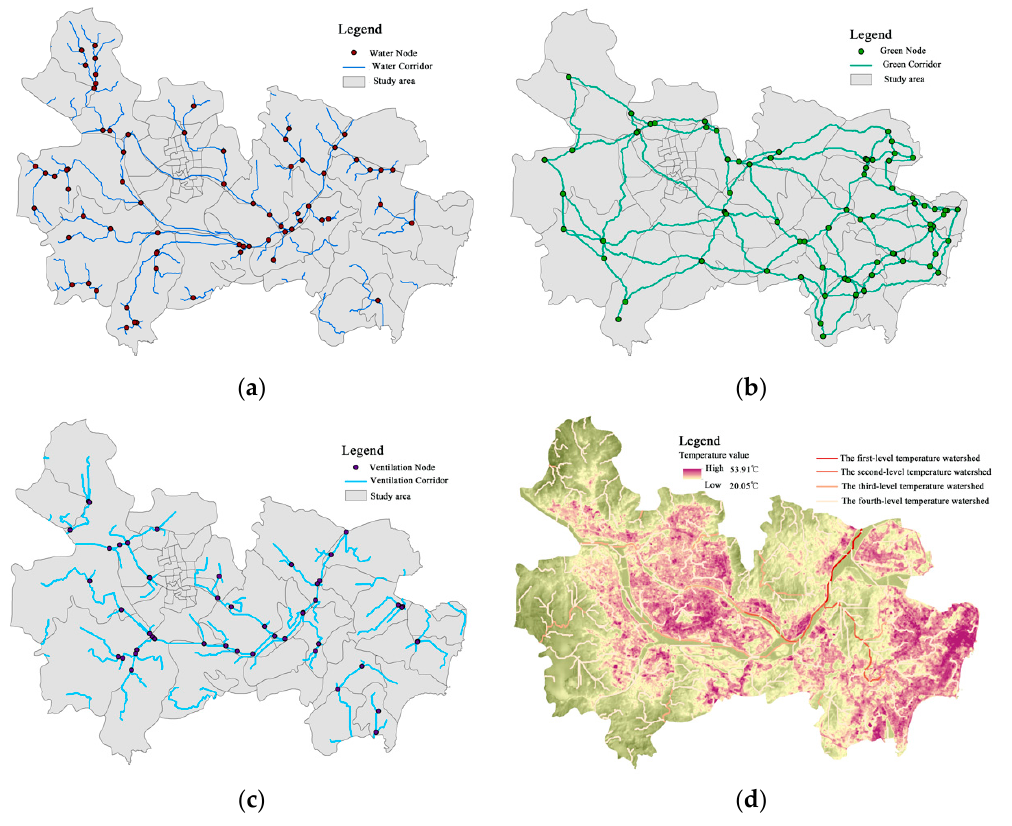
Figure 2. Corridors and temperature watershed maps. ( a ) Water corridors. ( b ) Green corridors. ( c ) Ventilation corridors. ( d ) Temperature watershed.